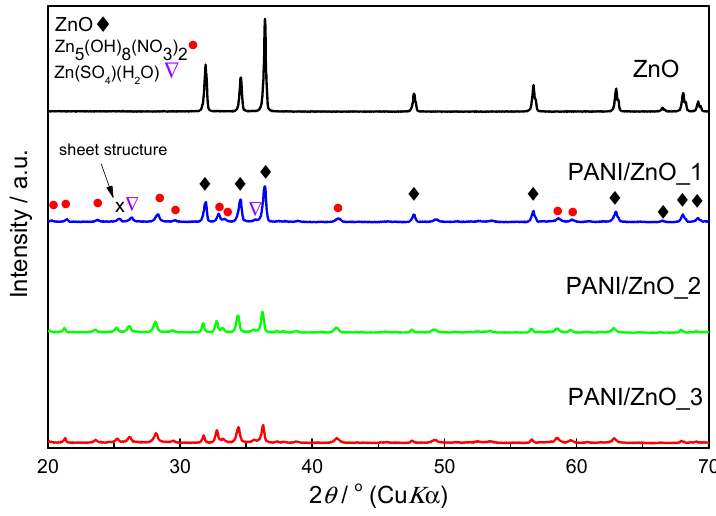
Figure 6. Di ff ractograms of the pure ZnO and the PANI / ZnO-based multiphase Figure 6. Diffractograms of the pure ZnO and the PANI/ZnO-based multiphase photocatalysts.